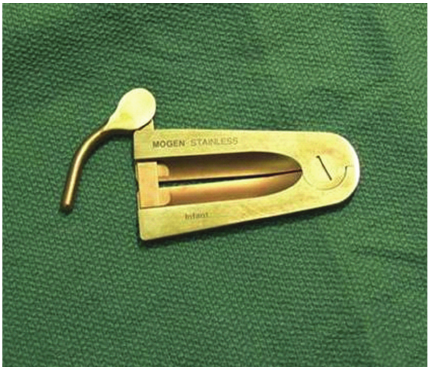
FIGURE 2: The Mogen clamp is used by drawing the skin to be removed into the V and then providing hemostasis followed by